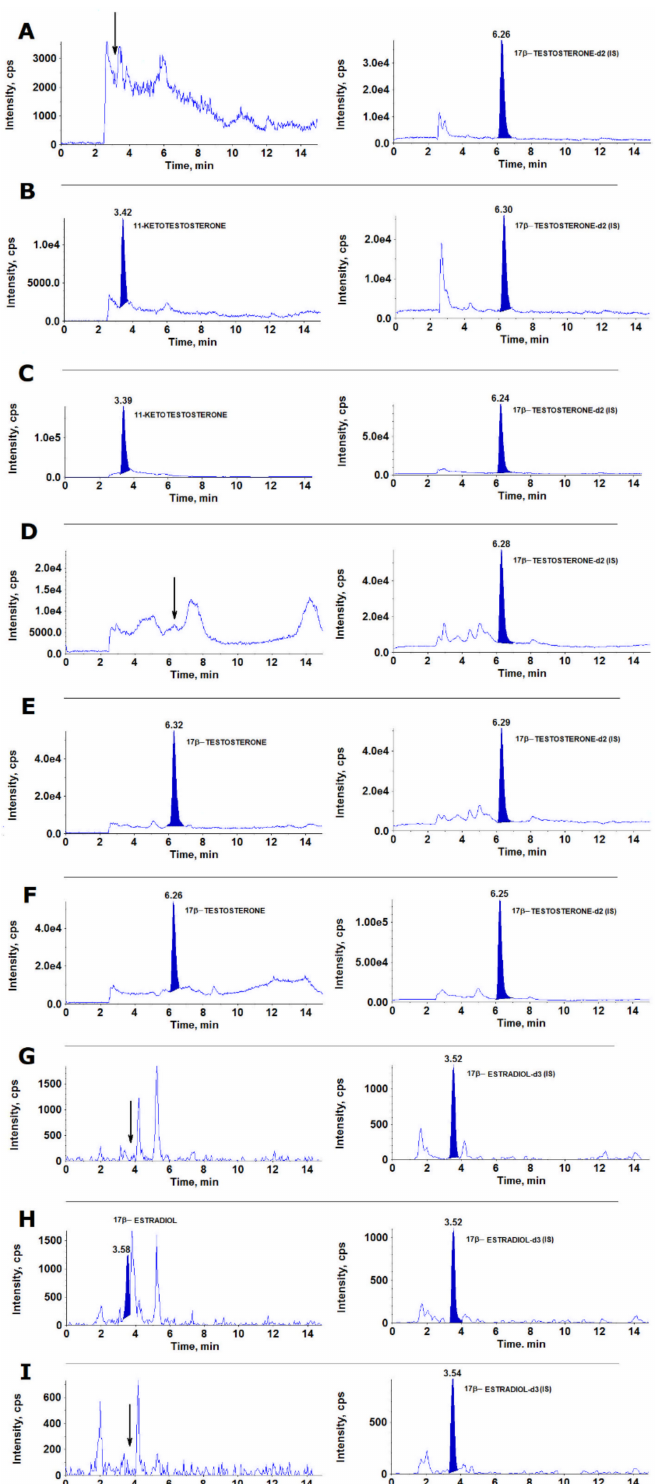
Figure 4. Ion chromatogram from the analysis of a male gonad sample: ( A )—blank sample for 11-KT; ( B )—sample spiked with 11-KT to the concentration of 5 ng/g; ( C )—sample with 11-KT at a concentration of 23.67 ng/g; ( D )—blank sample for 17 β -T; ( E )—sample spiked with 17 β -T to a concentration of 1 ng/g; ( F )—sample with 17 β -T at a concentration of 0.57 ng/g; ( G )—blank sample for 17 β -E2; ( H )—sample spiked with 17 β -E2 to a concentration of 1 ng/g; ( I )—sample tested with no 17 β